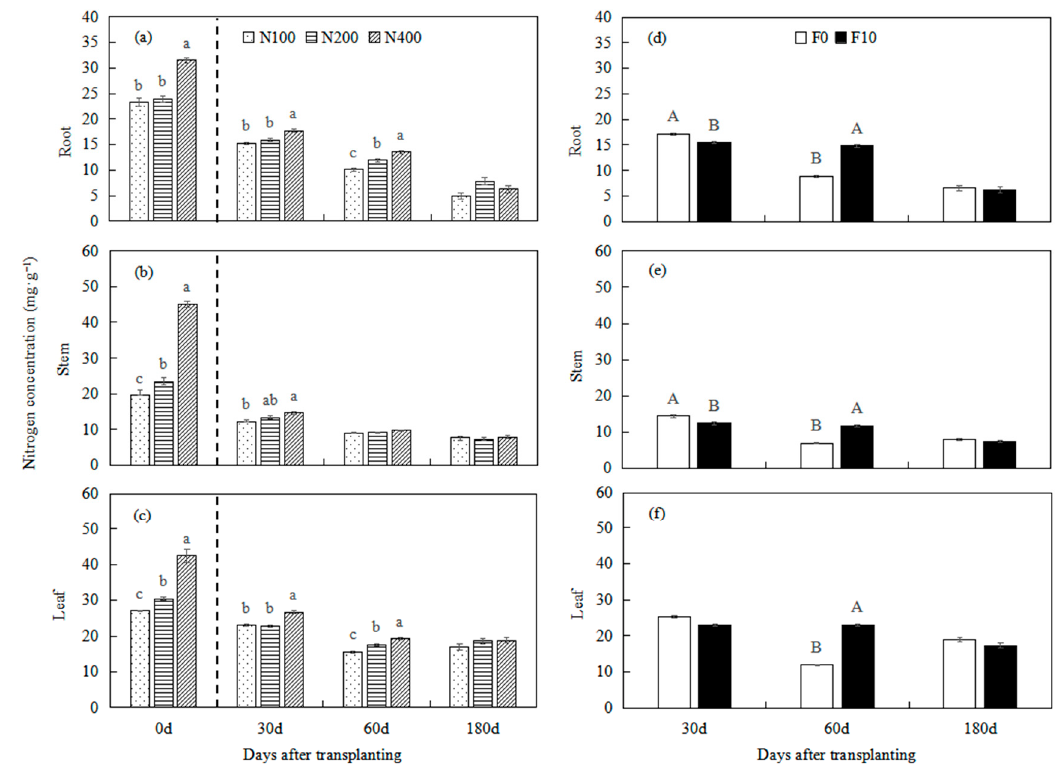
Figure 3. The main effects of nutrient loading (N) and fertilization at transplanting (F) on Betula alnoides nitrogen concen- trations in plant tissues. Different lowercase (a, b, c) and uppercase (A, B) letters represent significant differences among nutrient loading and between transplanting fertilization treatments, respectively, within each sampling time at p < 0.05 according to Duncan’s multiple range test. Vertical bars are standard errors of the means (n = 6 in ( a – d ) or n = 9 in ( e – h )). See Table 3 for ANOVA summary.